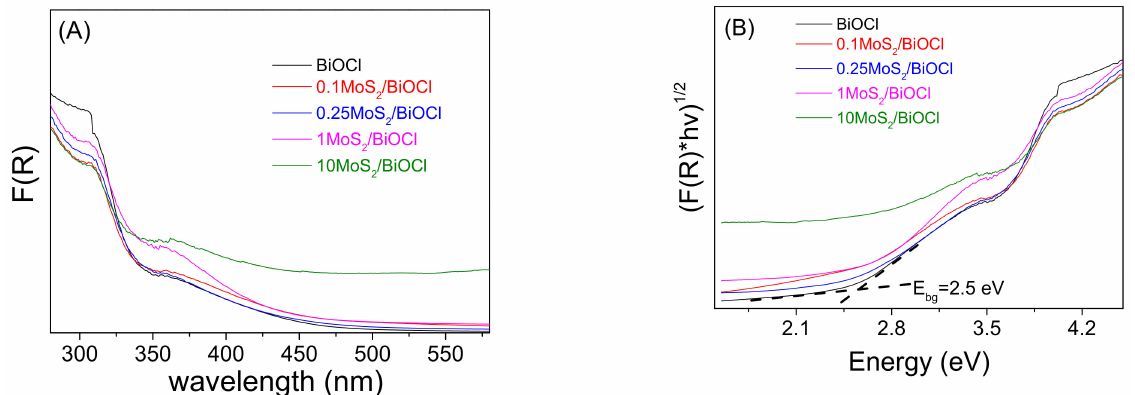
Figure 3. ( A ) UV–vis diffuse reflectance spectra obtained for for pure BiOCl and MoS 2 /BiOCl photocatalysts. ( B ) Tauc plot obtained from the DRS spectrum.